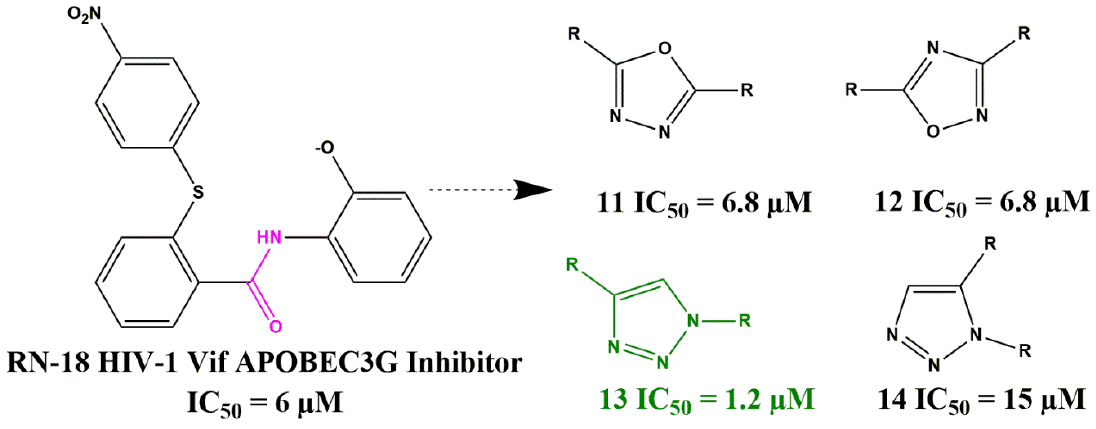
Figure 9. Heterocyclic bioisosteres of the RN ‐ 18 HIV ‐ 1 Vif inhibitor class and IC 50 values obtained from a multi ‐ round infection assay (HIV ‐ 1 LAI) using H9 and MT ‐ 4 cells.